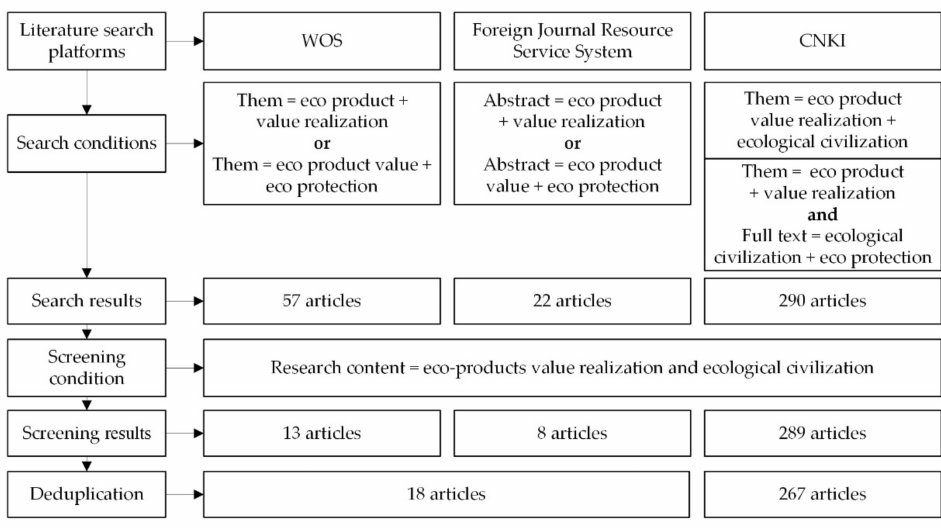
Figure 2. The process of the literature search and